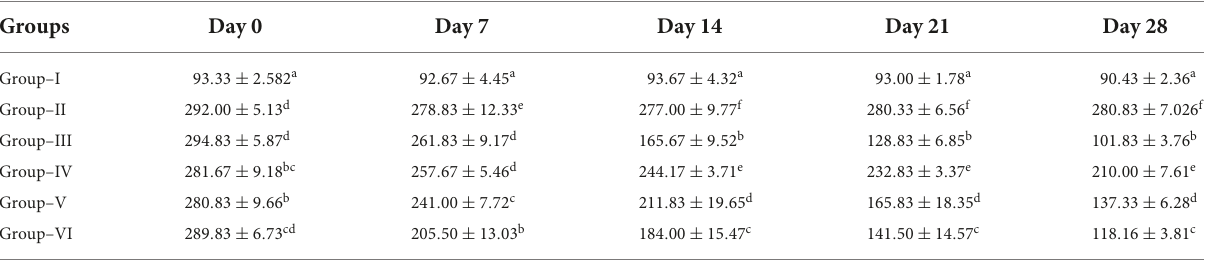
TABLE 3 Effect of ethanol extract of Solanum torvum fruits on fasting blood glucose level in streptozotocin (STZ)-induced diabetic Sprague–Dawley (SD) rats. Fasting blood glucose mg/dl